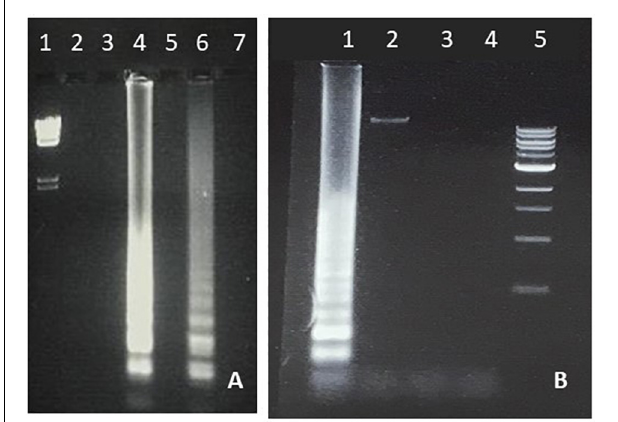
FIGURE 1 | LAMP amplification of E. coli. (A) Temperature optimization of E. coli LAMP. Lane 1, lambda Hin dIII marker. Lanes 2, 4, and 6 were generated with chromosomal DNA and Lanes 3, 5, and 7 with water as negative control. Lanes 2 and 3 were incubated at 70 ◦ C, Lanes 4 and 5 at 66 ◦ C and Lanes 6 and 7 at 62 ◦ C. (B) Specificity of E. coli LAMP. Lane 1; E. coli , Lane 2; S. typhimurium , Lane 3; Staphylococcus aureus , Lane 4; water, Lane 5; 1 Kb marker. All reactions were carried out at 66 ◦